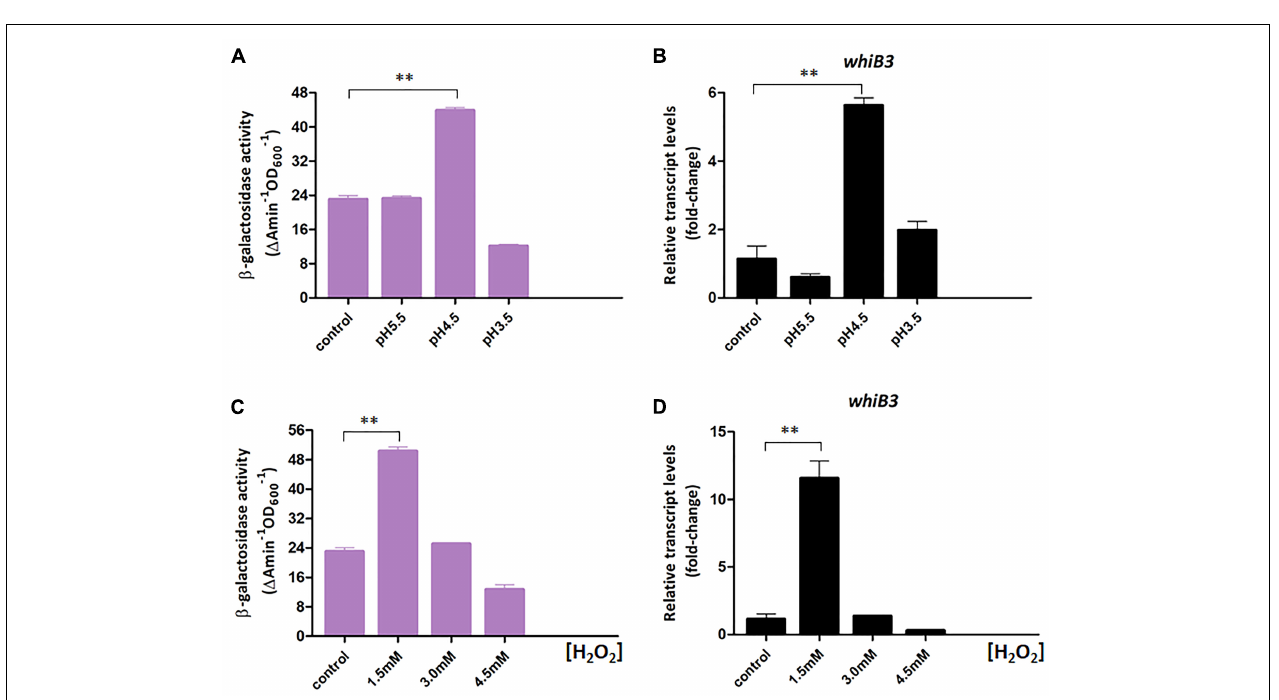
FIGURE 3 | WhiB3 is responsible for response to environmental stress. (A) The β -galactosidase activity of M. smegmatis WT strain under different pH conditions. (B) The expression of whiB3 under different pH conditions. (C) The β -galactosidase activity of M. smegmatis WT strain under different H 2 O 2 concentrations. (D) The expression of whiB3 under different H 2 O 2 concentrations. Error bars represented standard deviations of three independent experiments. ∗∗ P <